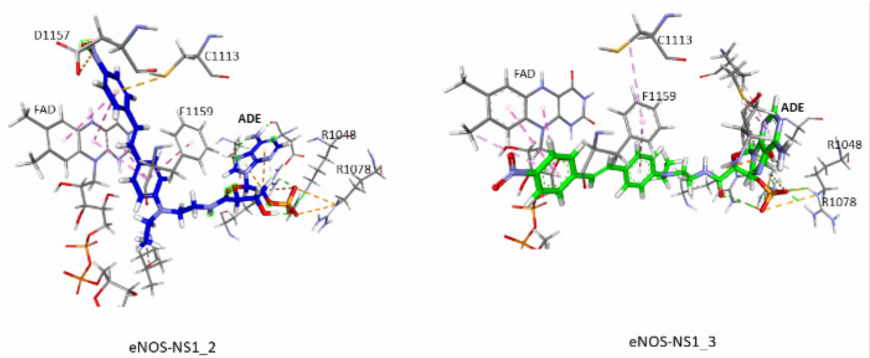
Figure 9. Binding of NS1-2 ( left , shown in blue) and NS1-3 ( right , shown in green) to eNOS reductase domain; the main residues involved in the interactions with eNOS are labeled. ADE stands for